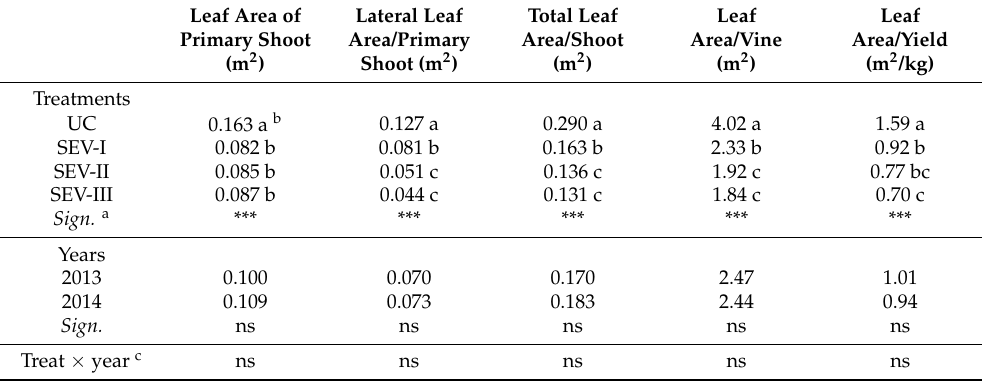
Table 1. Leaf area of Merlot grapevines subjected to severe shoot trimming at different phenological stages (mean values for 2013 and 2014). UC, untreated control; SEV-I, severe shoot trimming when berries were 4 mm in diameter; SEV-II, severe shoot trimming at early veraison; SEV-III, severe shoot trimming at late veraison. Leaf Area of Primary Shoot (m 2